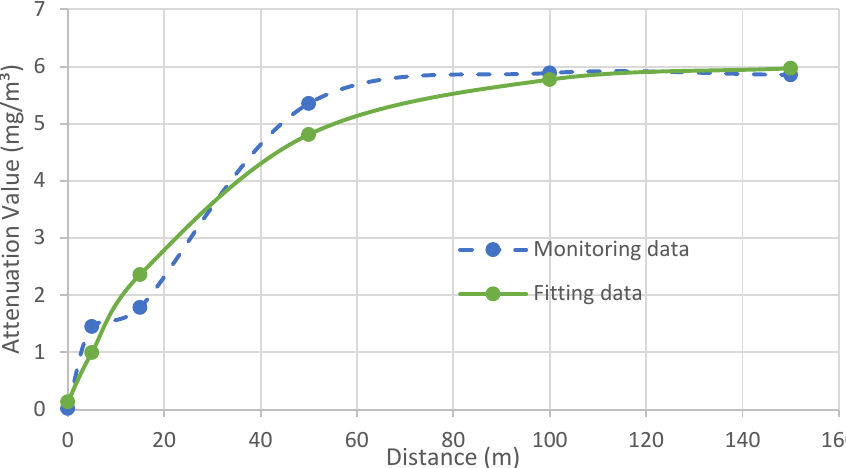
Figure 2. The construction dust concentration attenuation relationship.